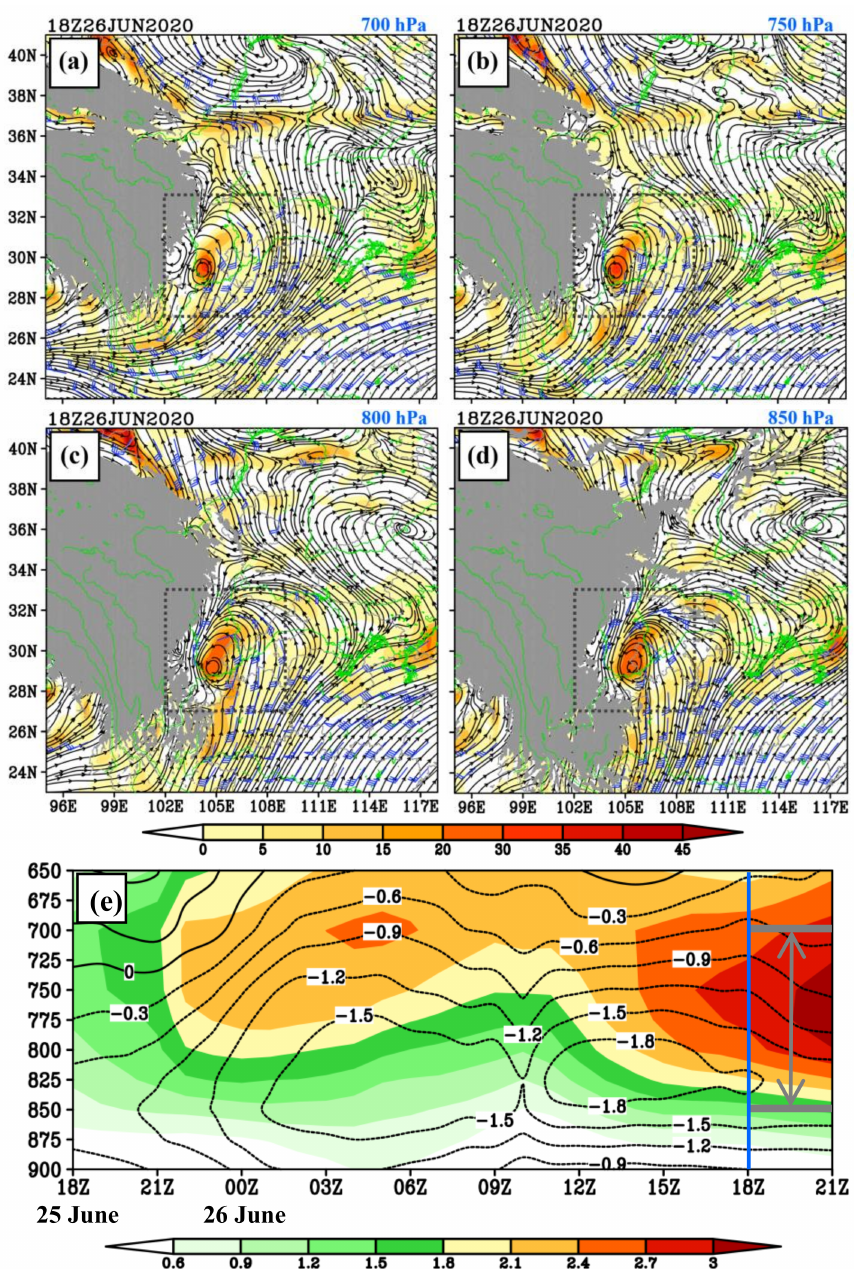
Figure 3. Panel ( a ) shows the stream field, vorticity (shading, units: 10 − 5 s − 1 ), and wind exceeding 8 m s − 1 (a full bar represents 4 m s − 1 ) at 750 hPa; Panels ( b – d ) are the same as ( a ), but for 750 hPa, 800 hPa, and 850 hPa, respectively. Abscissa is longitude, and ordinate is latitude. Grey shading outlines the terrain higher than 3000 m in ( a ), 2500 m in ( b ), 2000 m in ( c ), and 1500 m in ( d ). Black dashed boxes show the key region of the southwest vortex. Panel ( e ) shows the key-region averaged vorticity (shading, units: 10 − 5 s − 1 ) and divergence (black contours, units: 10 − 5 s − 1 ), where the blue solid line marks the formation time of the southwest vortex, and the thick grey solid lines with double arrows show the vertical range of the southwest vortex. Abscissa is time, and ordinate is pressure (units: